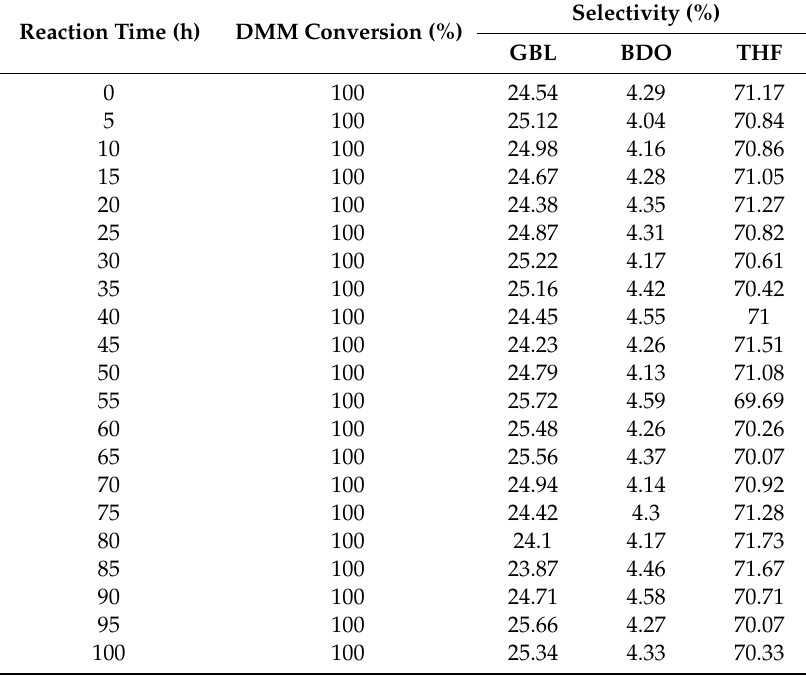
Table 3. The influence of time on the Cu-La / SiO 2 catalytic performance. Reaction Time